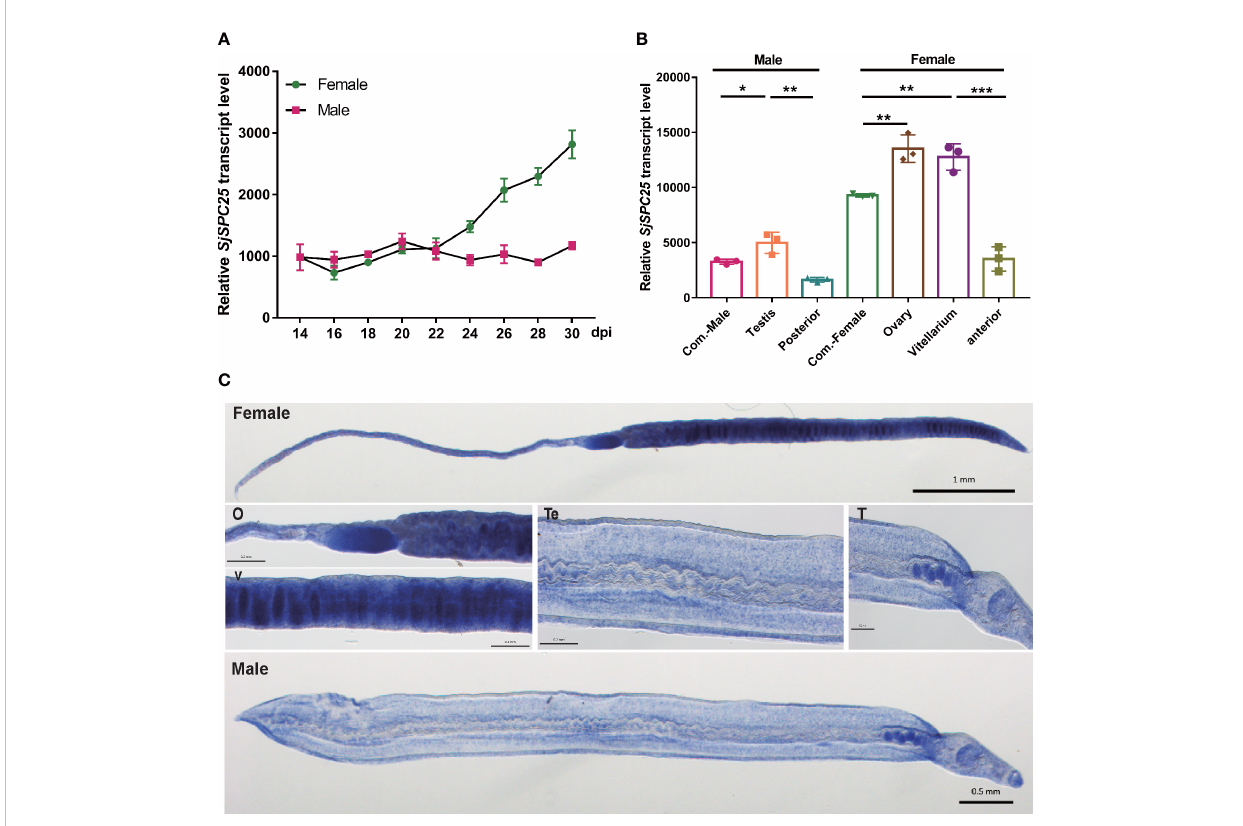
FIGURE 3 Pro fi les of the SPC25 transcript level. (A) SPC25 mRNA expression level in male and female worms at different development stages of S.japonicum . (B) The transcript level of SPC25 at isolated reproductive organs. All experiments were performed in triplicate with three biological replicates, and each group ’ s data were shown as means ± SEM. (C) In situ hybridization analysis of SPC25 in the male and female worms. Te, tegument; T, testis; O, ovary; V, vitellarium. * p < 0.05, ** p < 0.01, *** p < 0.001,